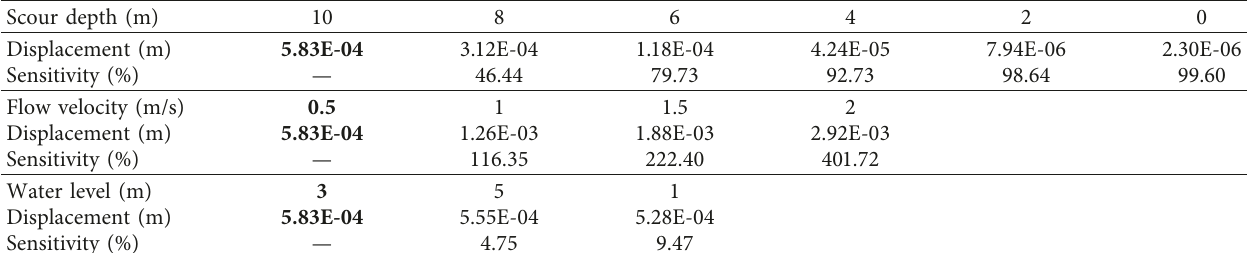
Table 4: Sensitivity test of boundary